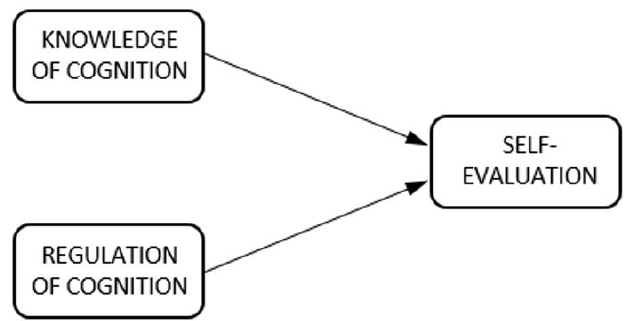
Figure 1. The framework of the components of metacognitive awareness in the present